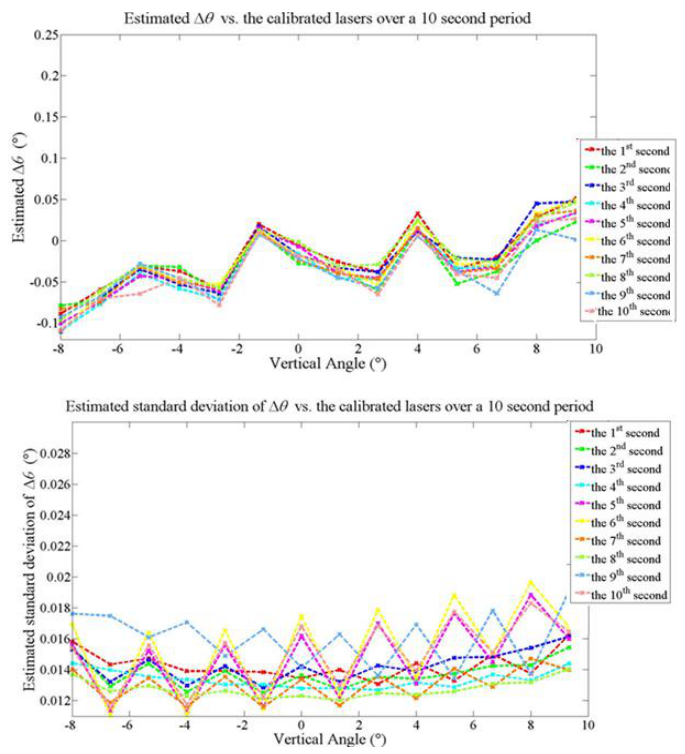
Figure 13. Estimated Δθ for Dataset 1 over a 10 second period (( a ) top). The standard deviations of estimated Δθ by the calibration for Dataset 1 over a 10 second period (( b )